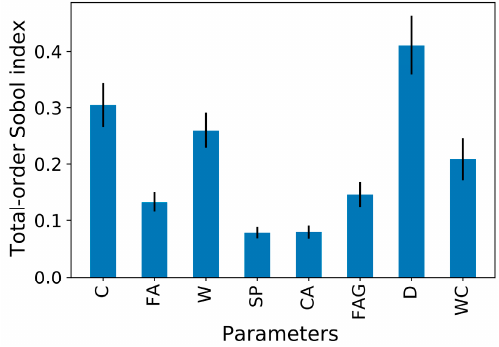
Figure 10. Sensitivity indices—total order index.